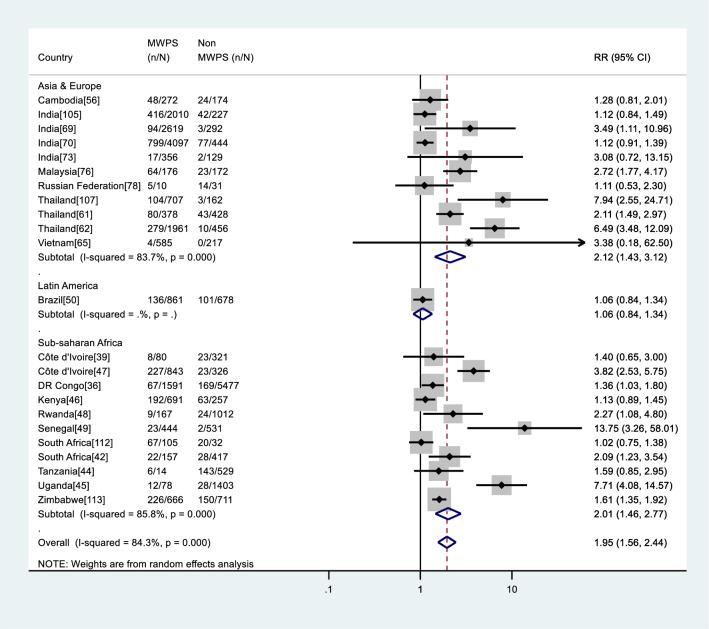
Meta-analysis of HIV risk in MWPS versus non-MWPS in LMICs by region.RR: Relative risk, n: Number of HIV positive, N: Number of samples.